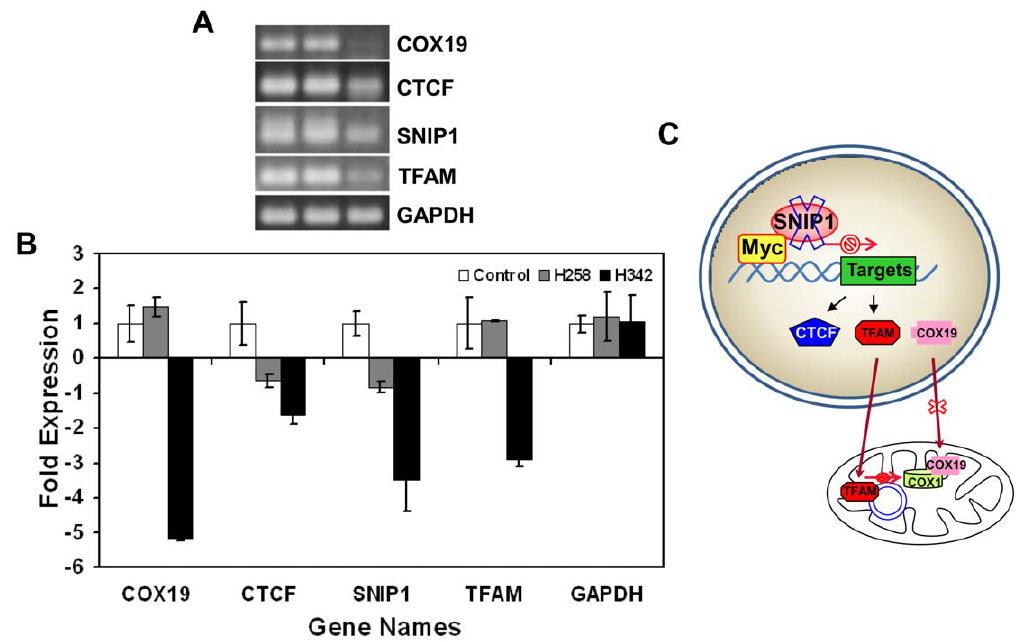
Figure 7. H342 downregulates SNIP1-stimulated gene expression of c-Myc target genes that are associated with mitochondrial function in H2373 MPM cells. A, Four gene products of the real-time RT-PCR were visualized after separation on an agarose gel. B, Comparing differences of PCR cycles of four genes. C, Schematic diagram of H342-induced mitochondria dysfunction through SNIP1 and COX19. In untreated H2373 MPM cells, C-terminus of nuclear protein SNIP1 interacts with the N-terminal c-Myc, resulting in enhanced transcriptional activation of c-Myc- dependent genes [30]. In addition, COX19 participates in the biogenesis mitochondrial respiratory chain complexes [35]. H342 rapidly attenuates gene expression of SNIP1 and consequently causes downregulation of c-Myc target genes such as TFAM, resulting in downregulation of gene expression of mitochondria such as COX1 [34]. COX19 downregulation fail to organize cytochrome c oxidase. Overall, these alterations of gene expression induced by H342 may lead to mitochondrial dysfunction, for good reason-H342-induced apoptosis is a mitochondria-mediated